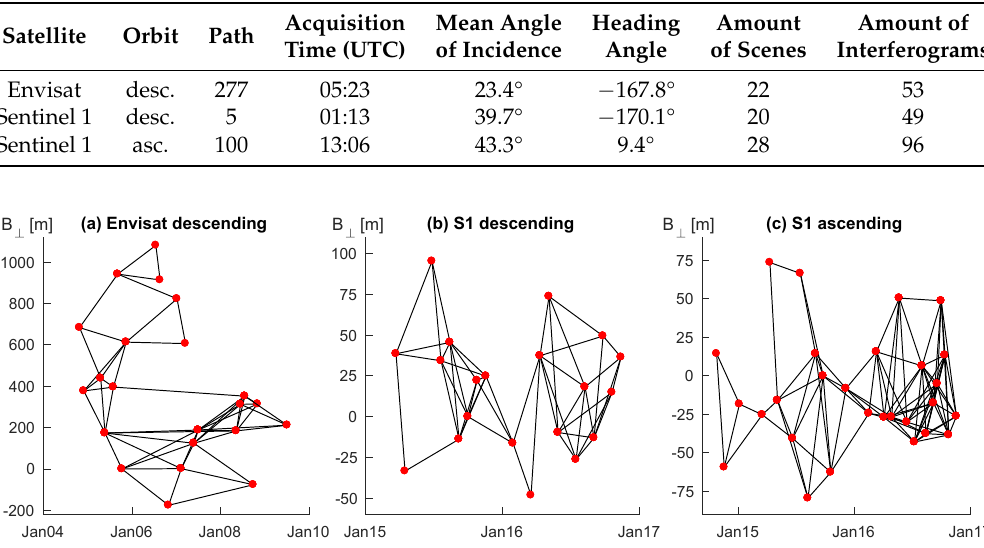
Table 1. SAR data specifications and summary of the amount of images used in the final networks. The covered time period that could be reliably unwrapped is as follows for the individual time series: